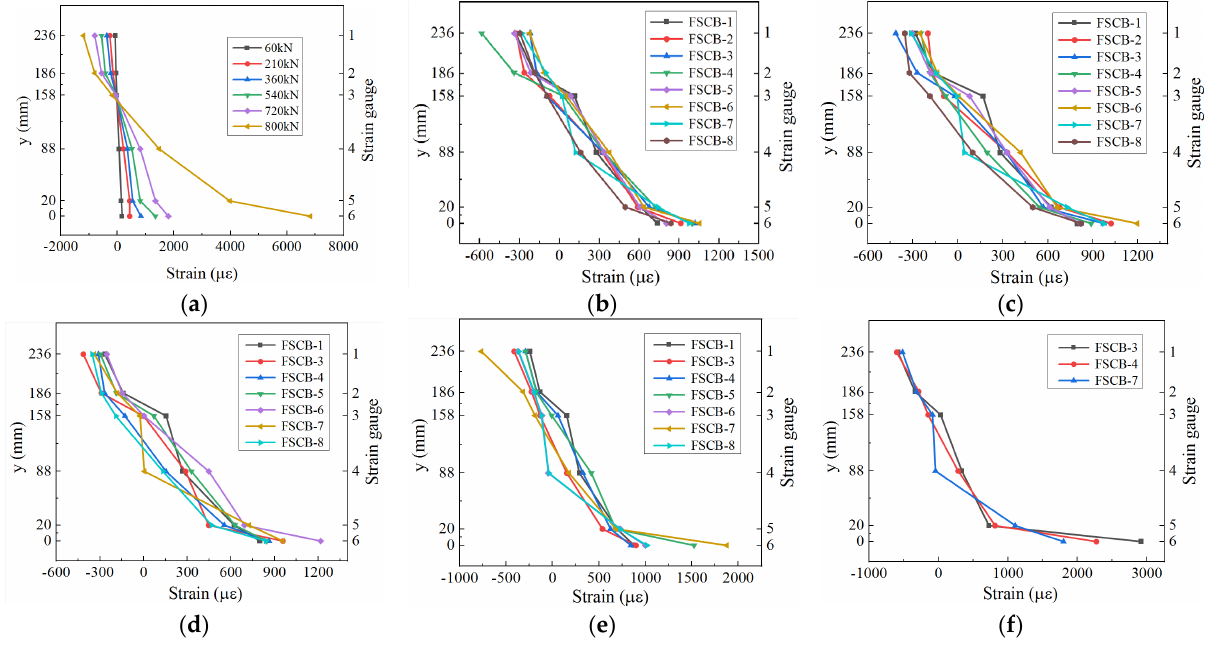
Figure 9. The distribution of strain along the height of the cross − section in the mid − span: ( a ) FSCB − 0; ( b ) N c = 0; ( c ) N c = 5.0 × 10 5 ; ( d ) N c = 1.0 × 10 6 ; ( e ) N c = 1.5 × 10 6 ; ( f ) N c = 2.0 × 10 6 . During the early stages of fatigue loading, the y − strain curves for FSCB − 1 to FSCB − 8 were similar and maintained linearity, conforming to the plane section assumption. However, when N c = 1.5 × 10 6 , FSCB − 5 and FSCB − 7 exhibited an average slope value of respectively, for strain gauges 5–6. When N c = 2 × 10 6 , FSCB − 3 and FSCB − 4 had an average slope value of 0.164 and 0.152, respectively, for strain gauges 1–5, and a slope value of 0.018 and 0.014, respectively, for strain gauges 5–6. This indicates that at the end of the static loading process or fatigue loading process, the steel box yielded below the height of